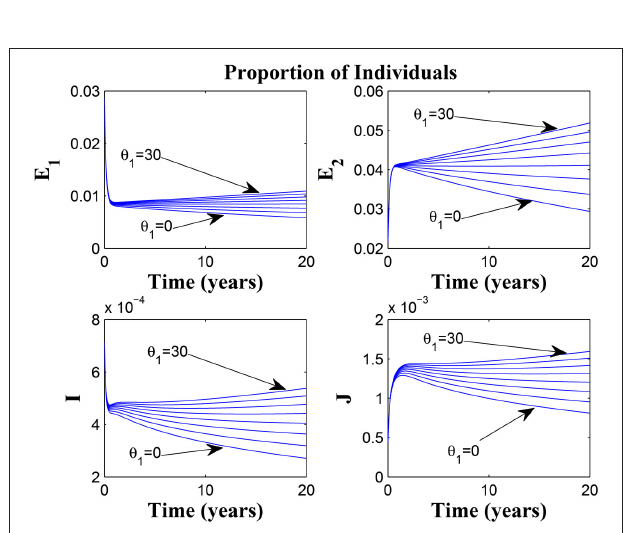
FIGURE 12 | Simulations of model (3) showing the number of infected individuals. Here, the disease transmission modification parameter ( η ) is varied from 0 to 1 with α 1 = α 2 = 5 , θ 1 = θ 2 = 1 and ψ = 30